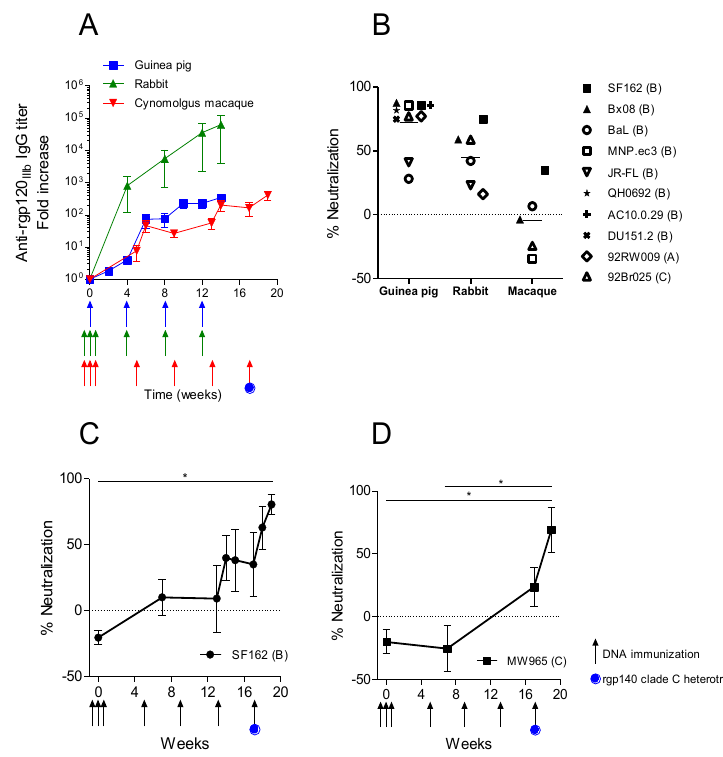
Figure 5. Comparison of immune response in guinea pigs, rabbits and cynomolgus macaques immunized with plasmid DNA encoding syn.gp140 . ( A ) Average IgG response mix against rgp120 in immunized animals (n = 4). Immunization time points are indicated with IIIb arrows. IgG titers in rabbits and guinea pigs were derived from Figure 2A,C. ( B ) Average percent neutralization against pseudotype virus strains of clade A–C, by week 14 rabbit IgG or guinea pig sera and week 17 macaque sera. From rabbit sera, IgG was purified and used in neutralization at one fixed concentration (250 or 400 µg/mL). Sera from guinea pigs